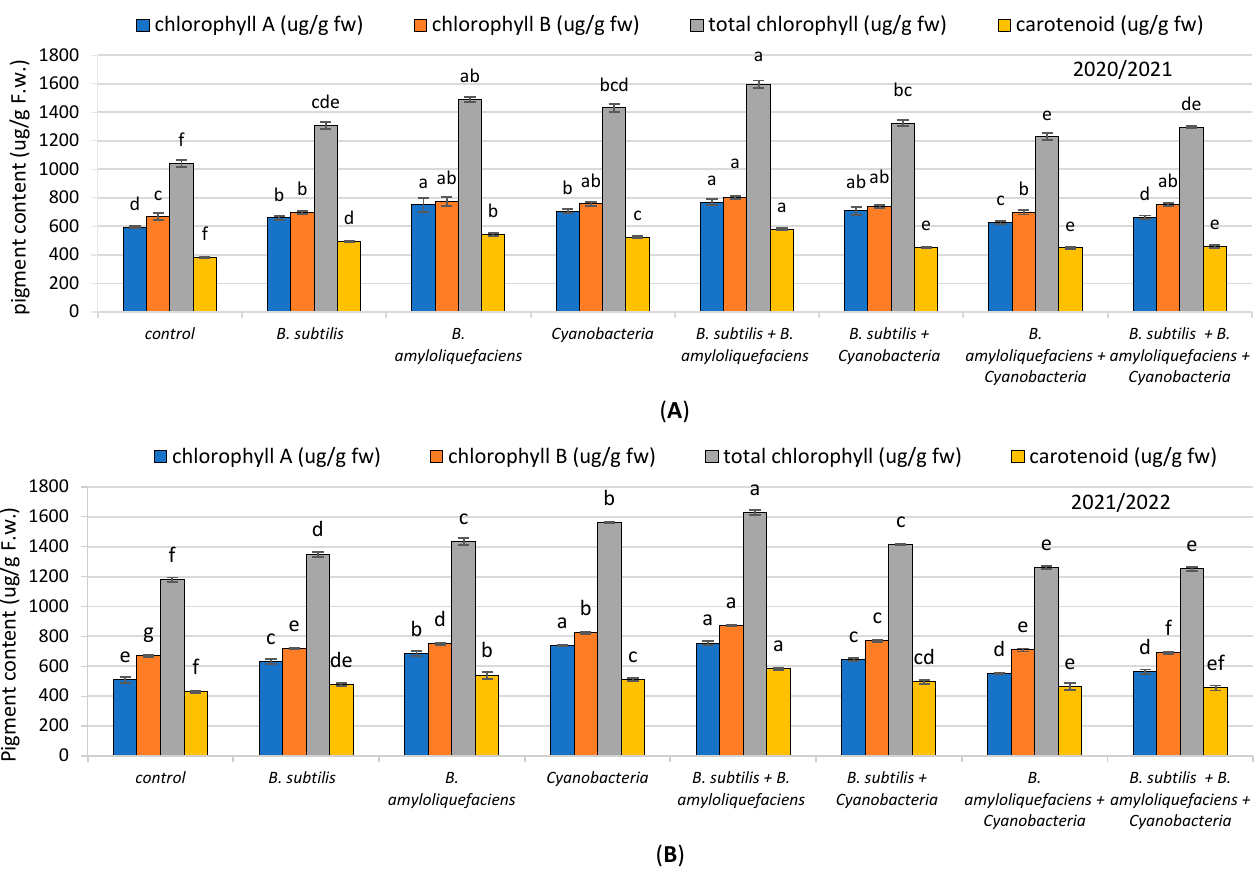
Figure 2. ( A , B ). The effect of inoculation with two PGPR strains ( B. subtilis and B. amyloliquefaciens ) and cyanobacteria on the pigment content ( µ g/g F.W.) of tomato plants in two seasons ( A ) (2020/2021) and ( B ) (2021/2022). Different letters indicate significant differences between treatments (ANOVA, LSD, p < 0.05). Error bars represent standard error of the mean.